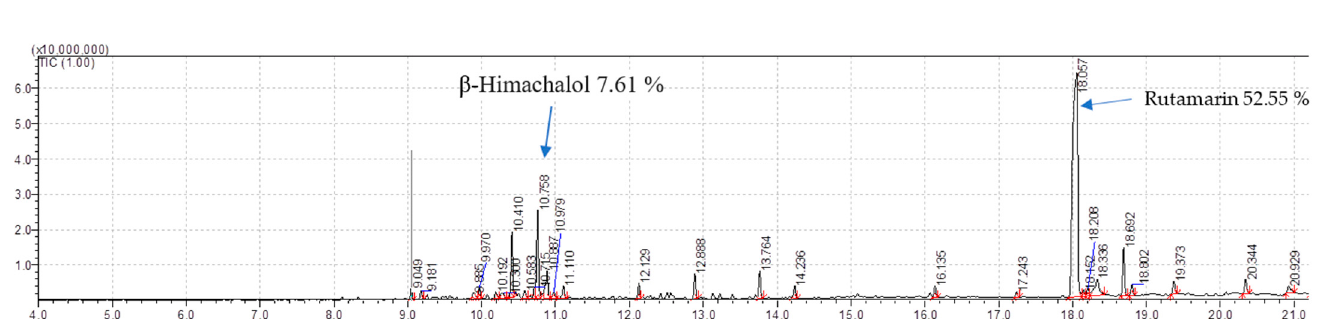
Figure 5. GC-MS/MS Chromatogram of isolated non-volatile oil B of root bark of T. ciliata. Table 11. Phytocompounds identified in isolated non-volatile oil B from the root bark of T. Ciliata by GC-MS/MS.